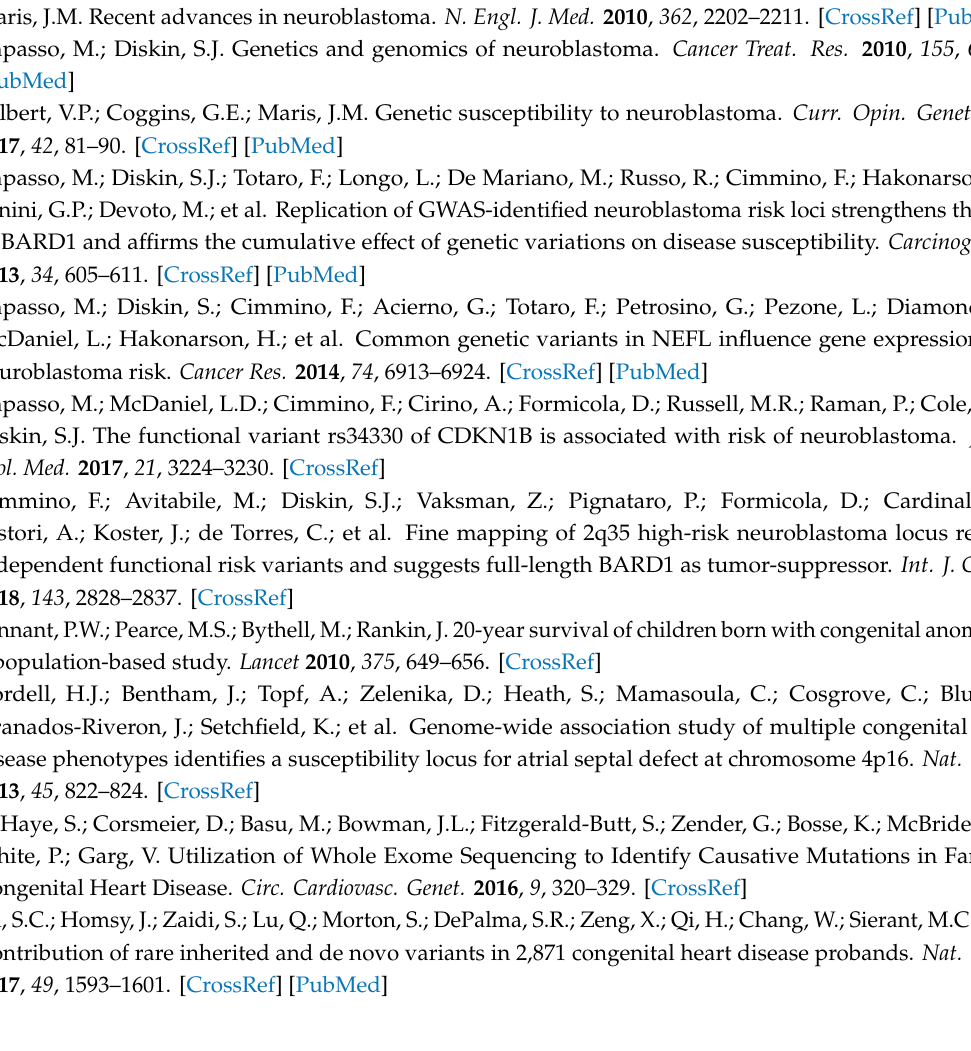
Figure S1: Manhattan plots of neuroblastoma (NB) and di ff erent types of congenital heart disease (CHD), Figure S2: Regional association plots of significant loci described in text, Table S1: Characteristics of patients in the neuroblastoma (NB) cohort, Table S2: Evaluation of the extent of shared genetic e ff ects between NB and congenital heart disease (CHD), Table S3: Evaluation of the extent of shared genetic e ff ects between NB and CHD via simulations, Table S4: Physical distance between lead SNPs in NB and the diverse CHD subtypes, Table S5: List of datasets used for epigenetic characterization of significant loci, Table S6: Annotation of epigenetic features in selected SNPs, Table S7: eQTL mapping performed in colocalizing susceptibility